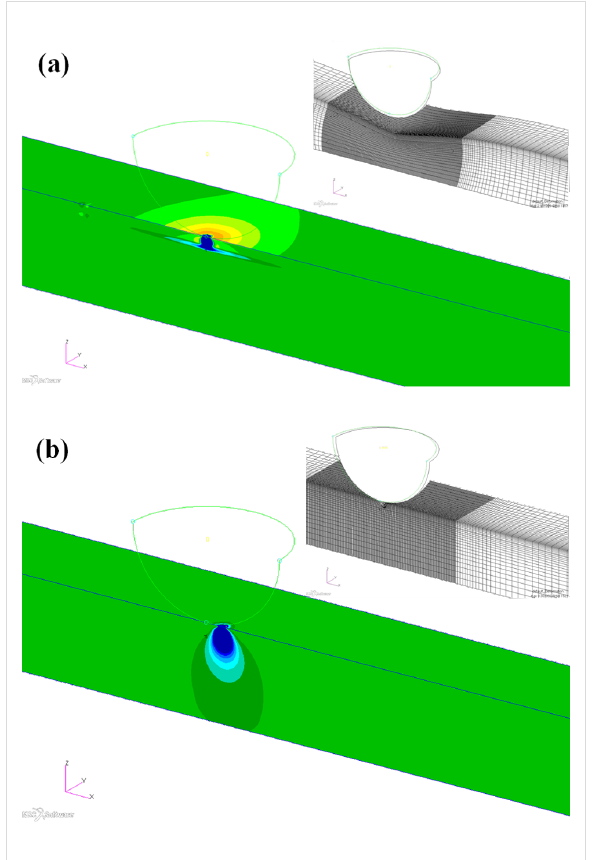
Figure 10: FEA model for 7 nm titania layer for 10 nN force showing z -component of global stress distribution for a) PDMS substrate, and b) Si substrate. Inset shows the deformation, with z enlarged by 7× for PDMS and 70× for Si. The color scale ranges from 50 MPa tensile (red) to 50 MPa compressive